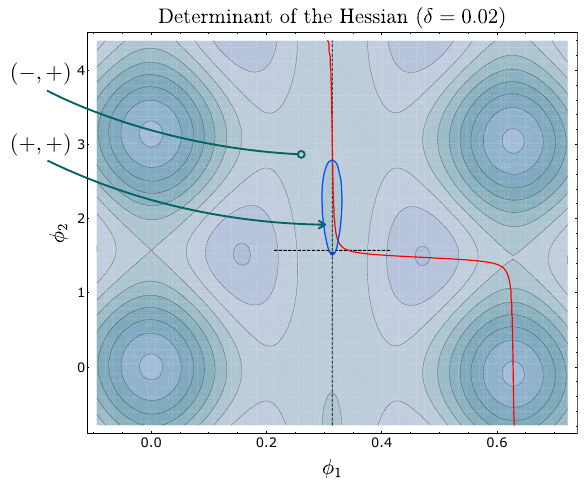
Figure 4 . Contour plot of the determinant of the Hessian of the deformed potential given in eq. (2.19) with c ± = c 1 (1 ± δ ) and c ± = c . We choose the same values of the parameters as in 1 2 figure 6, namely δ = 0 . 02 , α = 0 . 01 , γ = 0 . 011 and c 1 = 10 . The red solid curve shows where the gradient of the potential in the φ 1 direction is vanishing, and provides initially a good proxy of the inflationary trajectory. The black cross, on the other hand, shows the vanishing of the gradient in case the Z 2 symmetry would be unbroken, that is, for δ = 0 instead. The highlighted central contour specifies where the determinant of the Hessian changes sign. This contour shrinks to zero size as δ → 0 , while the rest of the contours remain